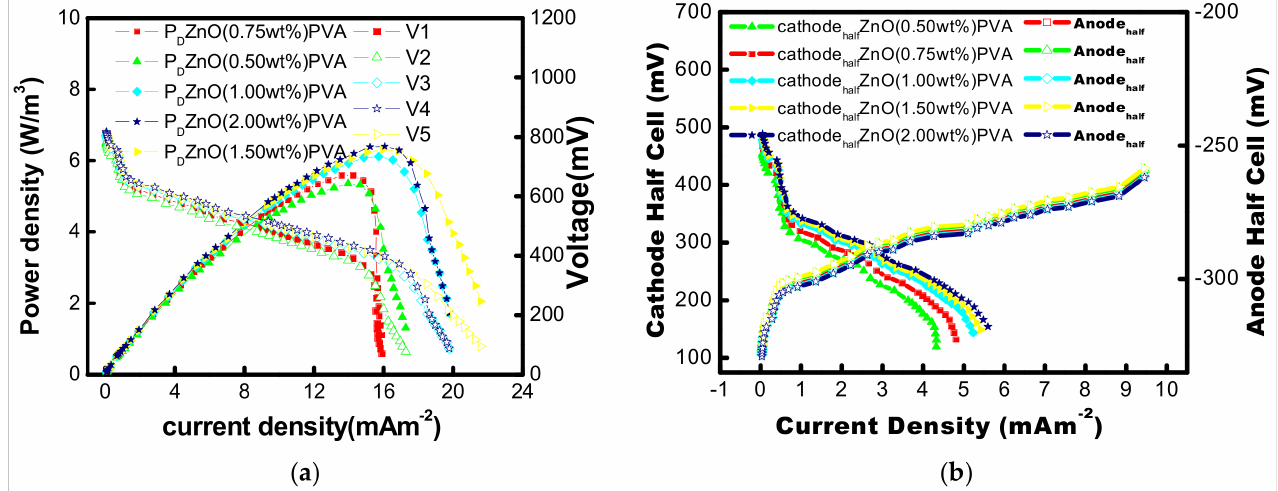
Figure 9. ( a ) The polarization curve of MFCs loaded with varying concentrations of Li-ZnO (0.50, 0.75, 1.00, 1.5, and 2.0 wt%). On the graph, the data points for voltage and power density are illustrated as solid and open symbols, respectively; ( b ) Half-cell polarization plots of MFCs with various (0.50, 0.75, 1.00, 1.5, and 2.0 wt%)-Li-ZnO concentrations. On the graph, the data points for the cathode half-cell and anode half-cell are shown as solid and open symbols,